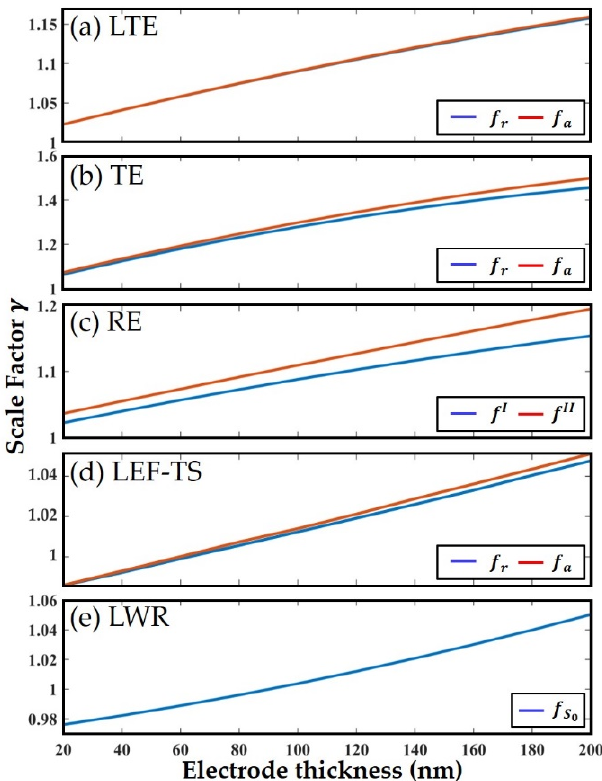
Figure 5. The shift curves of the scale factor γ with different electrode thickness (20–200 nm): ( a ) length thickness extension, ( b ) thickness extension, ( c ) radial extension, ( d ) lateral electric field excited thickness shear mode resonators and ( e ) lamb wave resonator.